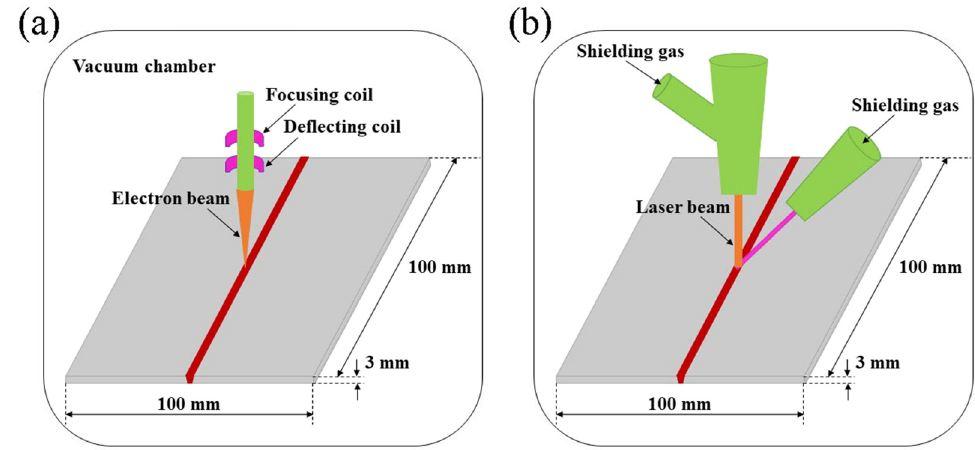
Figure 2: Schematic diagram of welding process: ( a ) EBW and ( b ) P -